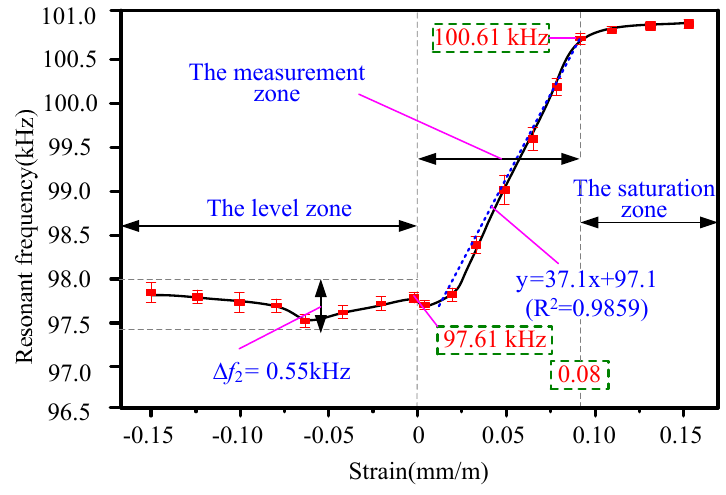
Figure 7. Plot of the resonant frequency of the HSMS versus the applied external strain.